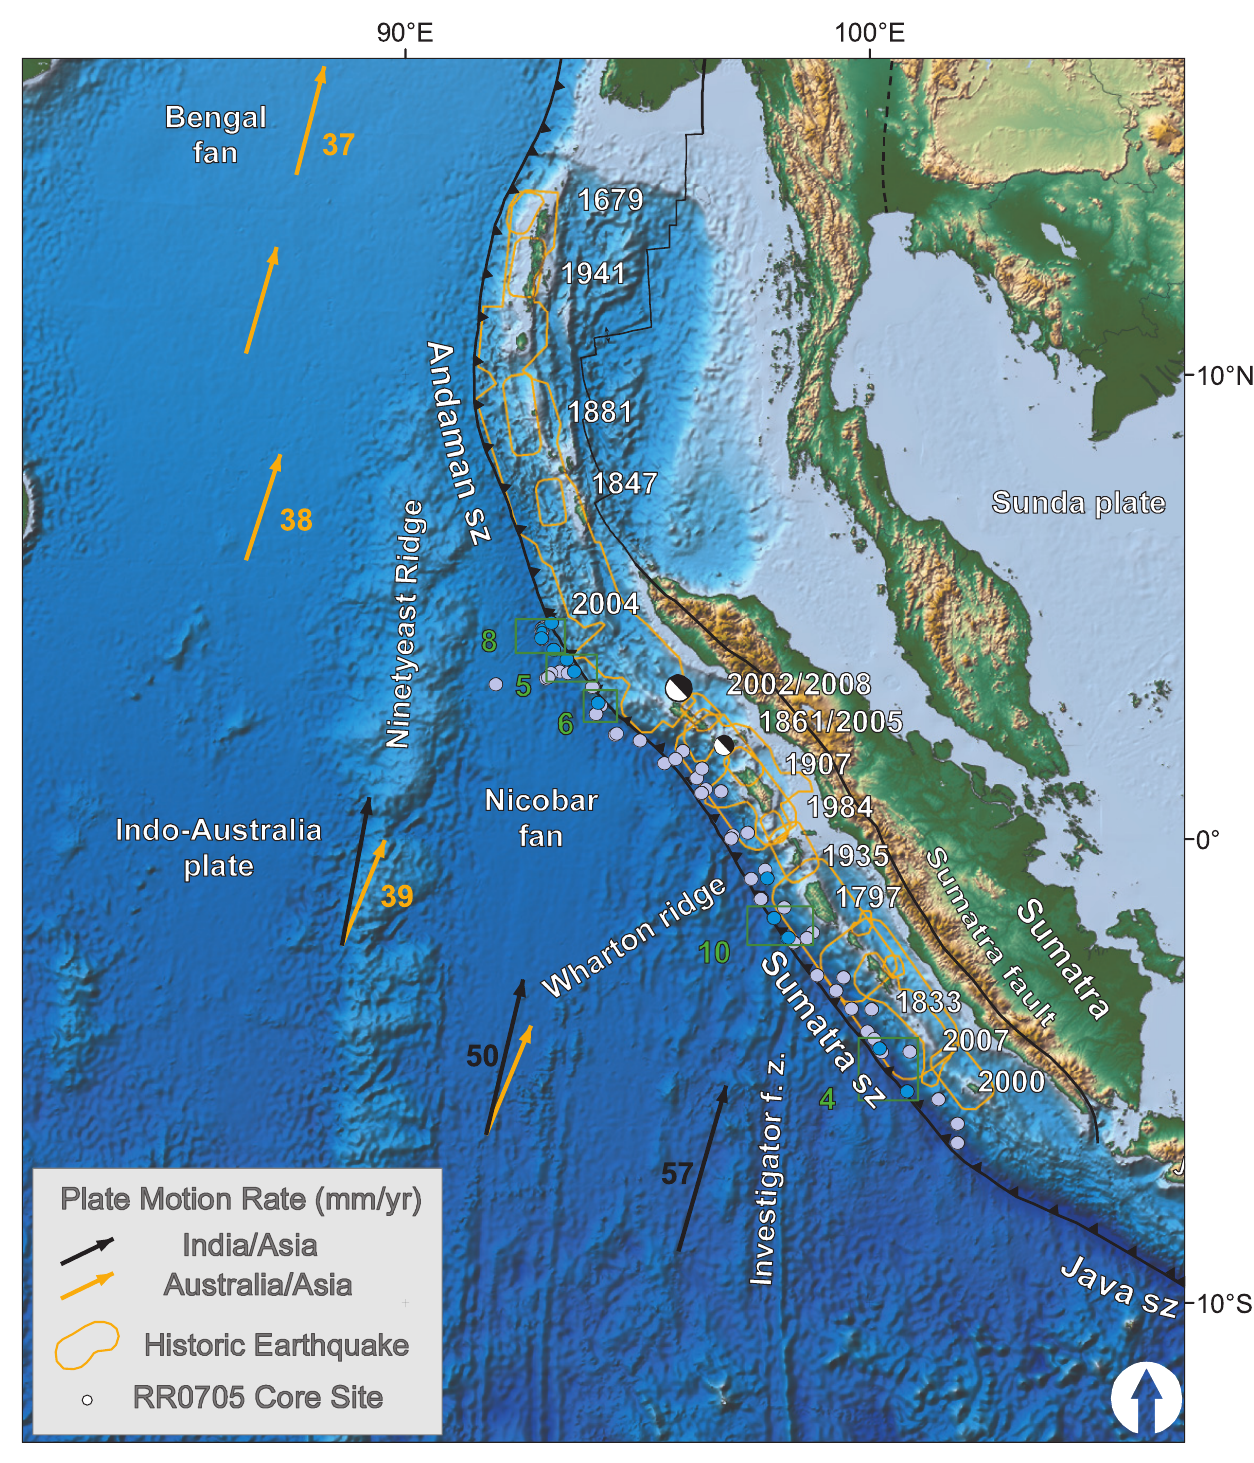
Fig. 2. Sumatra core location and plate setting map. India-Australia plate subducts northeastwardly beneath the Sunda plate (part of Eurasia) at modern rates (GPS velocities are based on regional modeling of Bock et al., 2003 as plotted in Subarya et al., 2006). Historic earthquake ruptures (Bilham, 2005; Malik et al., 2011) are plotted in orange. Bengal and Nicobar fans cover structures of the India-Australia plate in the northern part of the map. RR0705 cores are plotted as light blue and cores discussed in this paper are darker blue. General location for Figs. 1, 5, 6, 8, and 10 are designated by green rectangles. SRTM bathymetry and topography is in shaded relief and colored vs. depth/elevation (Smith and Sandwell,